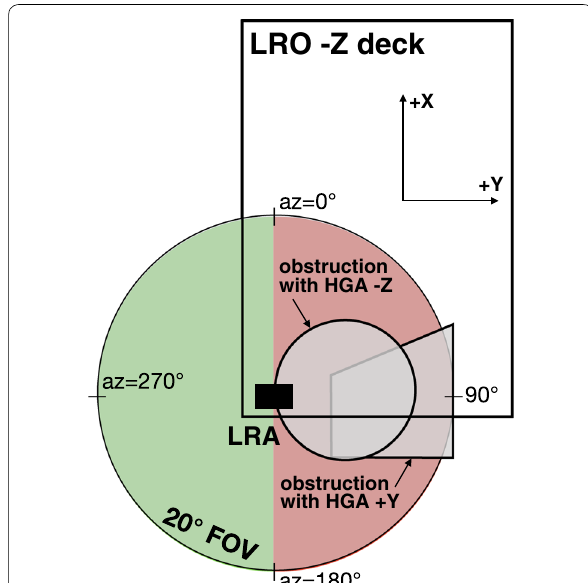
Fig. 5 Location of LRA on the LRO ‑Z deck. Partial obstruction occurs due to the HGA and HGA boom. The green half‑disk shows the preferred region for the Earth station when conducting two‑way laser